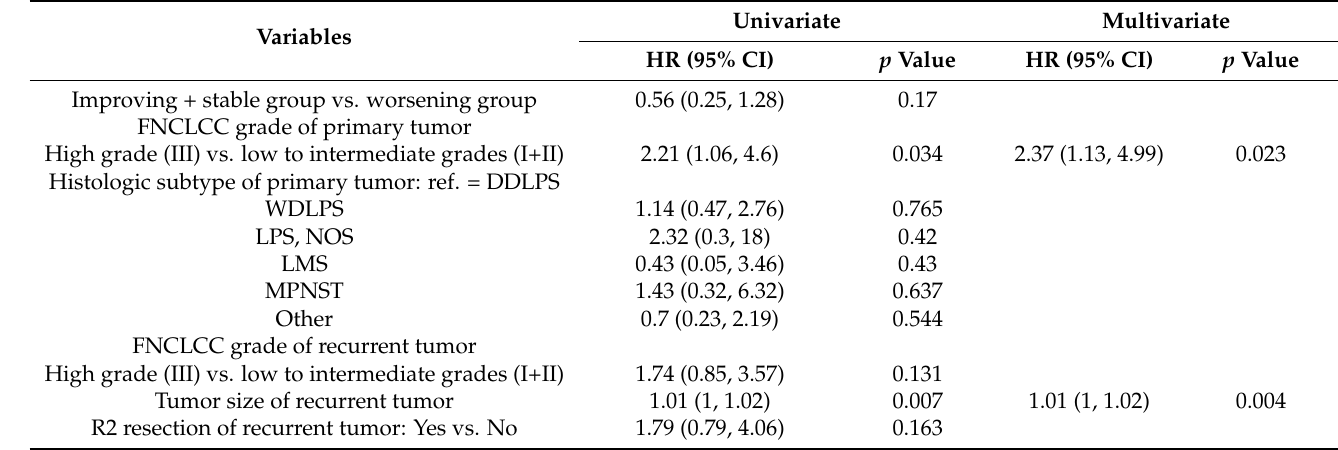
Table 3. Univariate and multivariate analyses of risk factors associated with overall survival.